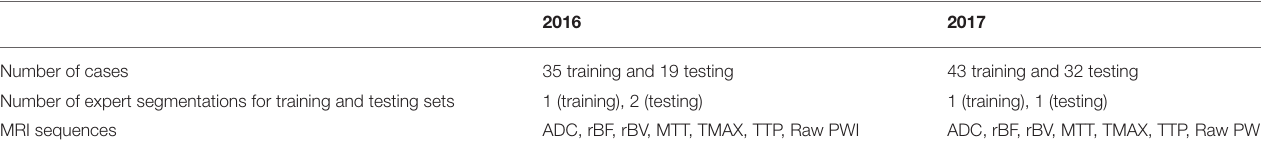
TABLE 3 | Details of the ISLES 2016 & 2017